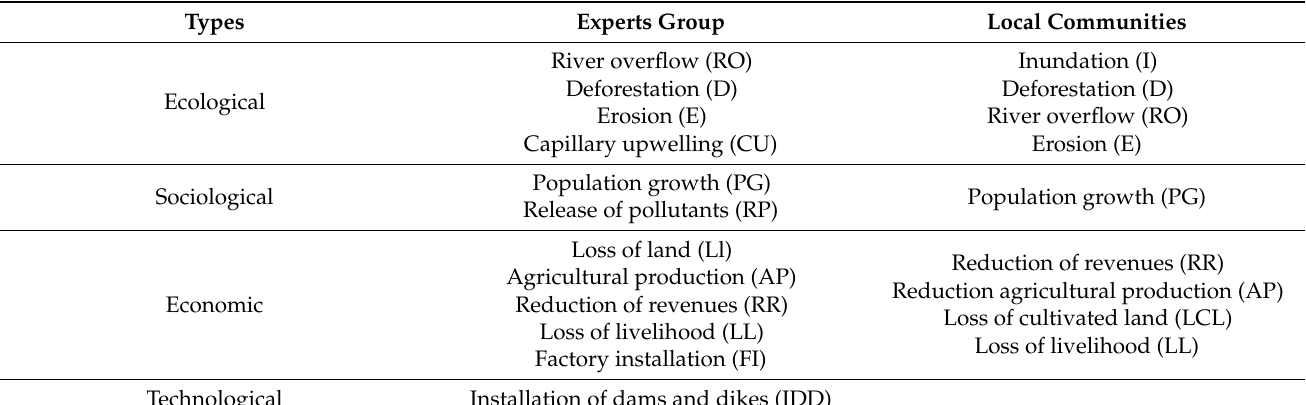
Table 5. Identification of dynamics/processes that drive changes in the Mono River